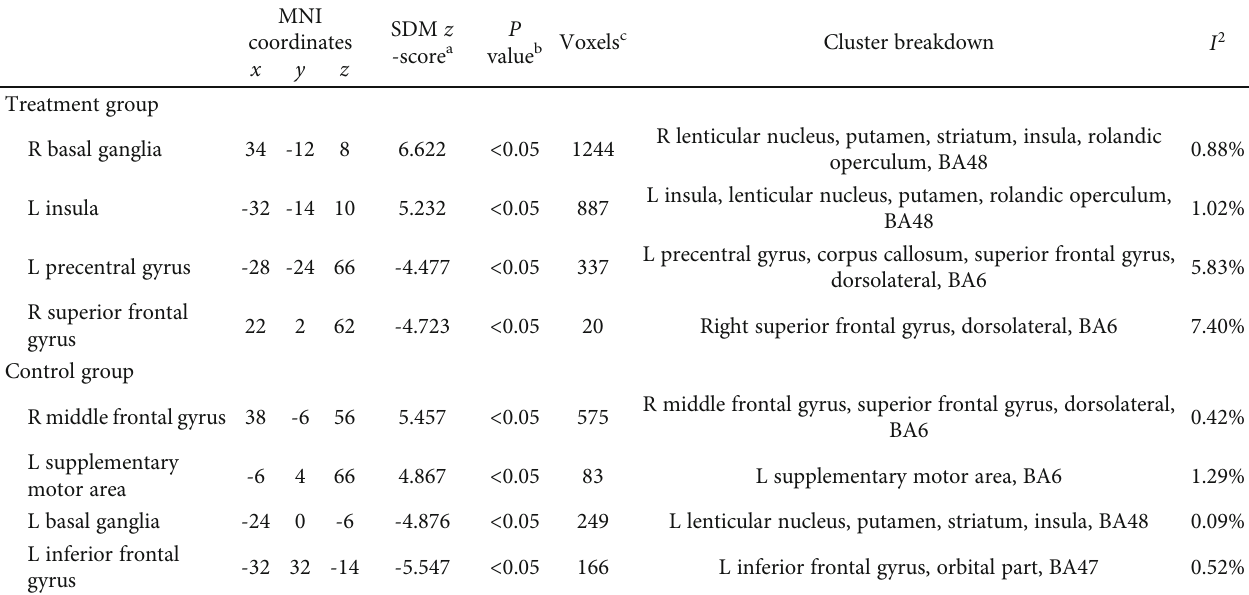
Figure 2: Risk of bias summary. Each color represents a level of risk of bias: light blue, low risk of bias; medium blue, unclear risk of bias; dark blue, high risk of bias. D1: random sequence generation; D2: allocation concealment; D3: blinding of participants and personnel; D4: blinding of outcome data; D5: incomplete outcome data; D6: selective reporting; D7: other sources of bias. Table 2: Brain activity changes in patients after treatment compared to